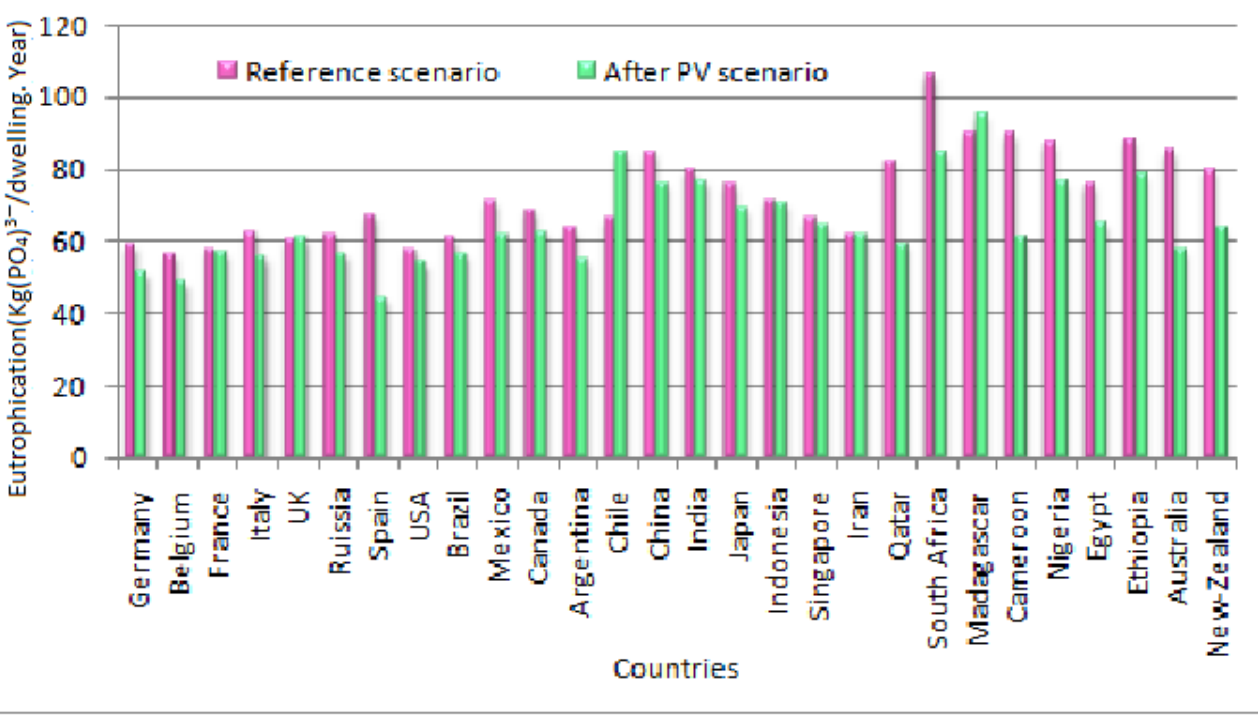
Figure 6. Comparative diagram of the eutrophication impact of the “Initial” and “Photovoltaic” scenarios.